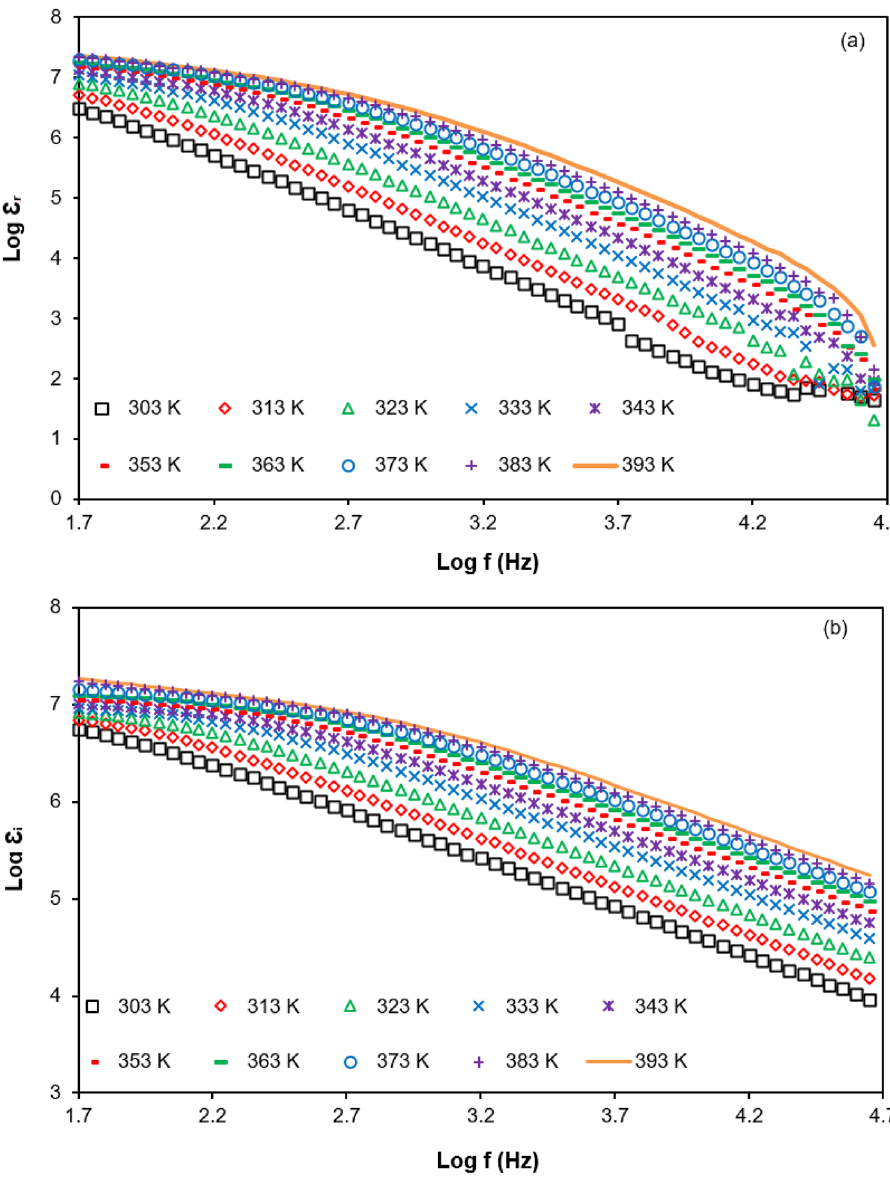
Figure 7. ( a ) Dielectric constant and ( b ) dielectric loss for PUA-30 wt% TBAI-I 2 GPE at selected